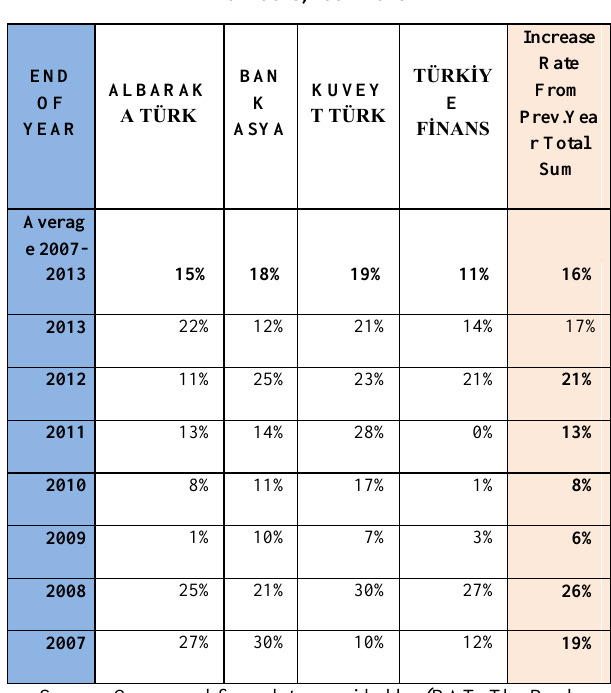
Table-3/b: Increase Rate from Previous Year at Branch Table-4/a: Employment in the Banking Sector, 2007-